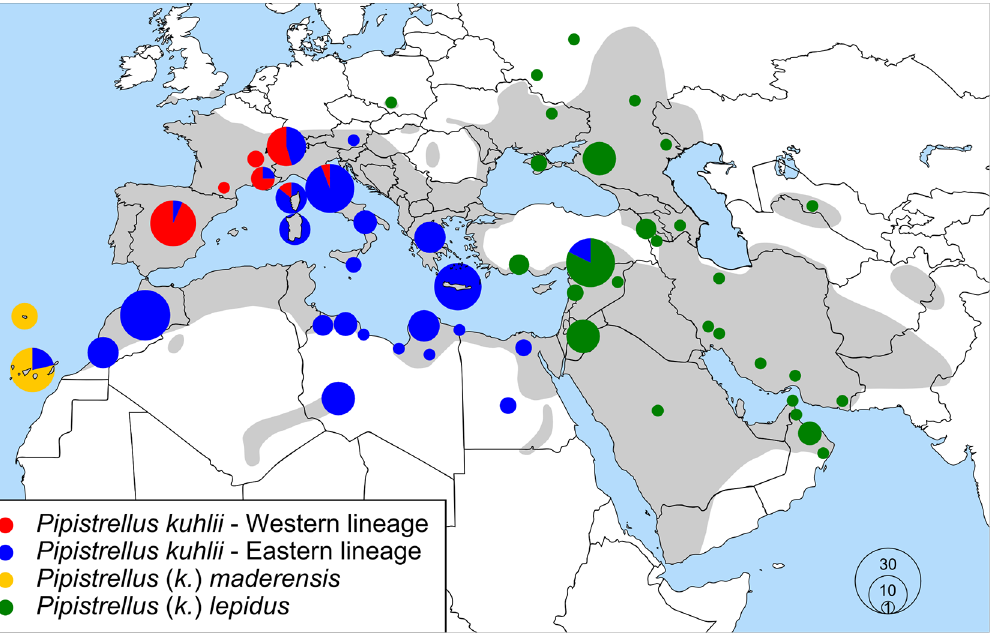
Fig 1. Distribution map of the four main mitochondrial lineages identified within the P . kuhlii species complex. In grey, the current distribution of this species complex based on Aulagnier et al. [23] and Benda et al. [24] and modified according to Dietz et al. [12] and Sachanowicz et al. [10]. Note that deserti is considered here as a desert morphoptype of P . kuhlii [13] and shares with the latter haplotypes of the Eastern lineage. Coloured dots represent the distribution of the main lineages identified from various mitochondrial markers (Mayer and von Helversen [25], Pestano et al. [14], Stadelmann et al. [26], Ibá ñ ez et al. [17], Mayer et al. [6], García-Mudarra et al. [18], Evin et al. [15], Veith et al. [20], Galimberti et al. [19], Kruskop et al. [21], Bray et al. [27], Çoraman et al. [16], Jesus et al. [28], Benda et al. [13], Benda et al. [8], Bogdanowicz et al. [29]). The inset provides the colour legend for each lineage. Circle size reflects the approximate number of sampled